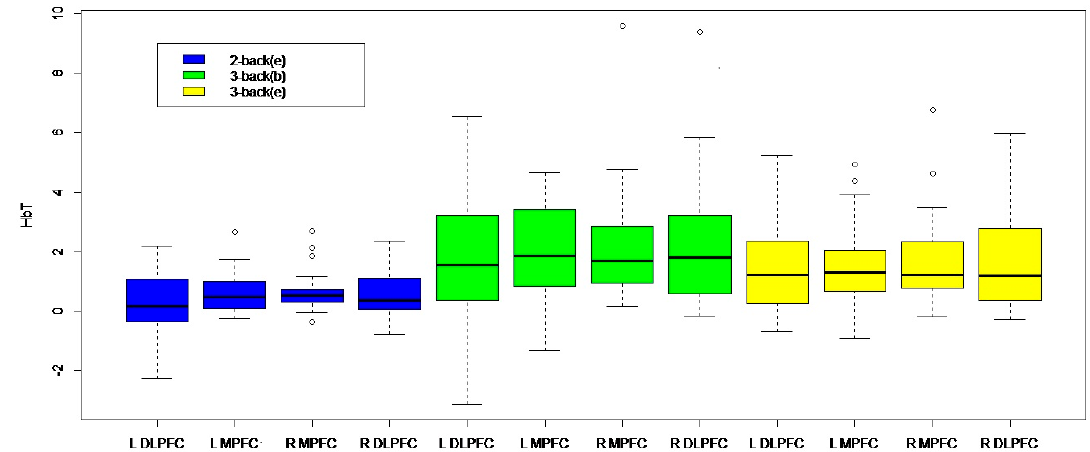
Figure 3. Difference in total hemoglobin (HbT) concentration between regions of interest (ROIs) and tasks. ROIs include the left dorsolateral prefrontal cortex (LDLPFC), the left medial prefrontal cortex (LMPFC), the right dorsolateral prefrontal cortex (RDLPFC) and the right medial prefrontal cortex (RMPFC). Bars are +/ − 1.5*IQR.